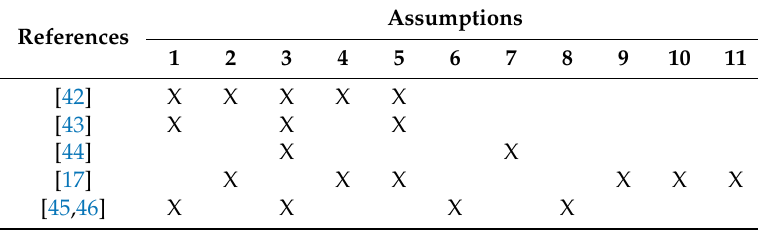
Table 3. Common exact methods and their assumptions (Assumptions numbered according to Table